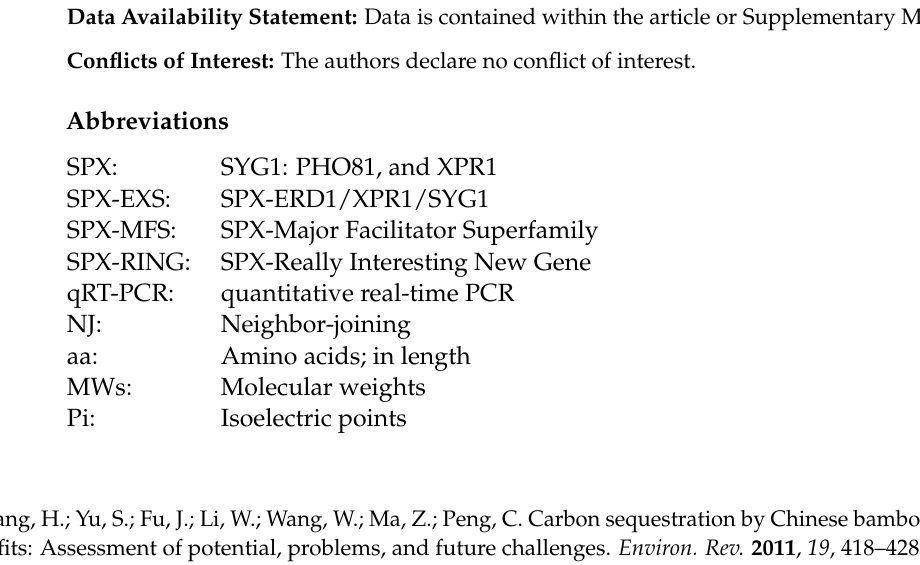
Table S2. Primers used in this study. Table S3. Transcription factor correlation analysis. Table S4. Transcription factors gene